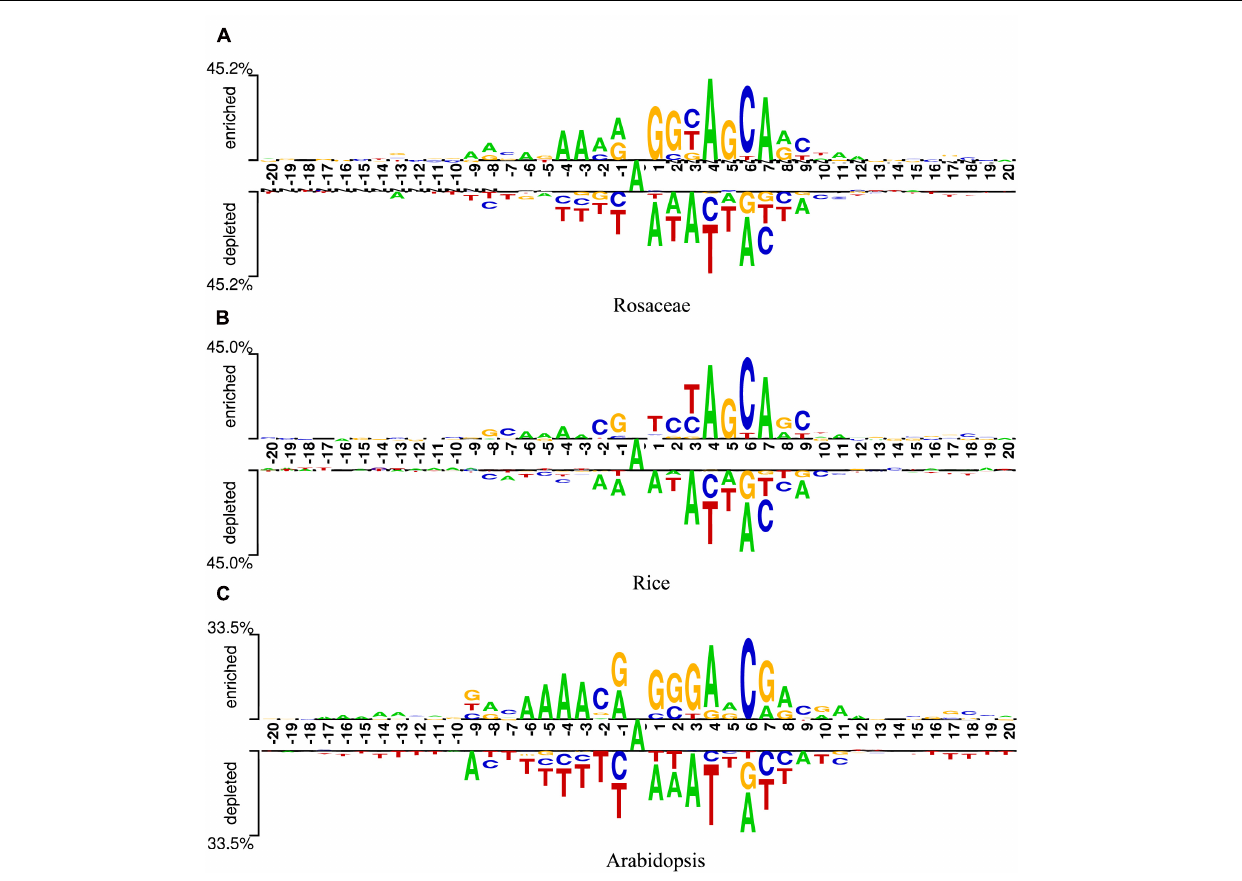
FIGURE 2 | Sequence logos of Rosaceae (A) , Rice (B), and Arabidopsis (C)